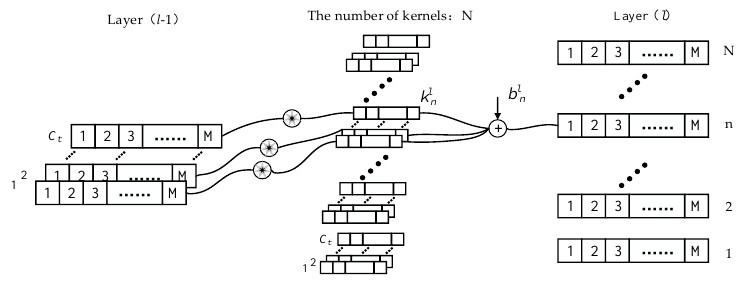
Figure 4. Illustration of 1d-CNN module.